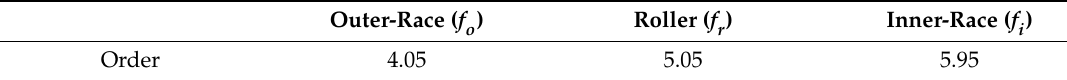
Figure 8. The angular domain waveform of the original signal. Table 1. Parameters of the